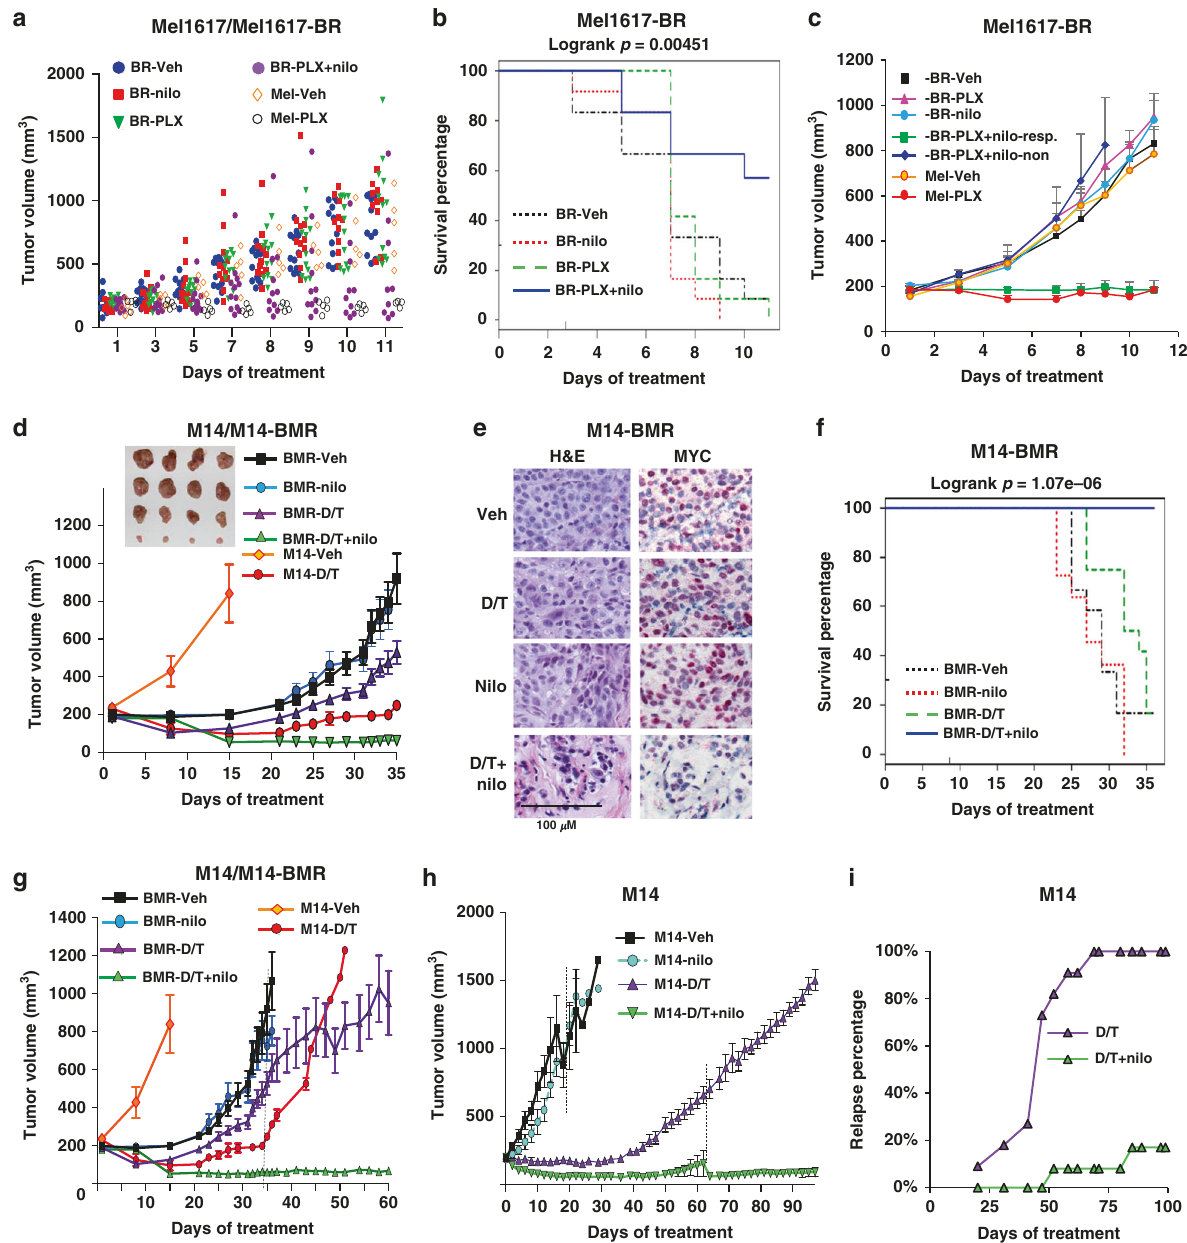
Fig. 8 Nilotinib reverses and prevents resistance, in vivo. a – c Mel1617-BR (BR) or parental cells (Mel) were injected s.q. into SCID-beige mice, and when average tumor size was 200mm 3 , Mel1617-BR mice were randomized to vehicle (Veh, n = 12), nilotinib (nilo, n = 12; 33mg/kg, b.i.d.), PLX4720 (PLX, 25mg/ kg, n = 12), or combination ( n = 11). Parental xenografts were treated with vehicle or PLX ( n = 5/group). Mice were euthanized when control tumors ≅ 1500 mm 3 (or were ulcerated). a Individual mouse tumor volumes over time. b Kaplan – Meier survival analysis comparing tumor doubling across groups. Percentage of mice not reaching the tumor doubling endpoint. Logrank p = 0.00451. PLX + nilo vs. vehicle, p = 0.0202; PLX + nilo vs. nilo, p = 0.0093; PLX + nilo vs. PLX, p = 0.0202 using pairwise comparisons and Holm ’ s multiple comparison adjustment. c PLX + nilotinib-treated mice were divided into responding ( n = 7) and non-responding ( n = 4) groups, and mean±SEM tumor volumes plotted. Some SEMs are too small to visualize. One-way ANOVA followed by Sidak ’ s multiple comparisons test for responding vs. other groups. veh, p = 0.0104; nilo, p = 0.0004; PLX, p = 0.0027; non-responding, p = 0.0116. d – g M14-BMR (BMR) or parental M14 (M14) xenografts were established in nude mice. BMR xenografts treated with vehicle, nilotinib (33mg/kg, b.i.d.), dabrafenib (25mg/kg/day) + trametinib (0.15mg/kg/day) (D/T), or D/T + nilotinib ( n = 12/group) when tumors were 200mm 3 . Parental xenografts were treated with vehicle or D/T ( n = 5/group). d Mean±SEM tumor volumes. Vehicle/nilotinib-treated mice and four mice from D/T and D/T + nilo groups were euthanized on d35. Linear mixed model analysis: for all comparisons, p = 3e − 04. e H&E and MYC immunohistochemical staining of representative tumors ( d ) from n = 4 mice/group. f Survival analysis. Time-to-tumor doubling on d35. Percentage of mice not reaching the tumor doubling endpoint. Logrank p = 1.07e − 06. Pairwise comparisons and Holm ’ s: p <6.46e − 05 for all groups. g D/T and D/T + nilotinib mice ( n = 8/group) were followed long term. Mean±SEM tumor volumes are shown. Dotted line indicates loss of euthanized mice (4/group). h , i In vivo prevention study. M14 parental tumors were established in nude mice, and mice treated with the indicated drugs. Vehicle, n = 5; nilo, n = 6; D/T, n = 11; DT + nilo, n = 12. h Mean±SEM tumor volumes. Dotted lines indicate loss of mice (high tumor volume and/or tumor ulceration). i Percentage of mice that developed resistance/relapse (tumors ≥ 300mm 3 ). Fisher ’ s exact test, p = 0.0000673 (two sided). Additional data and statistics related to these experiments are shown in Supplementary Fig.